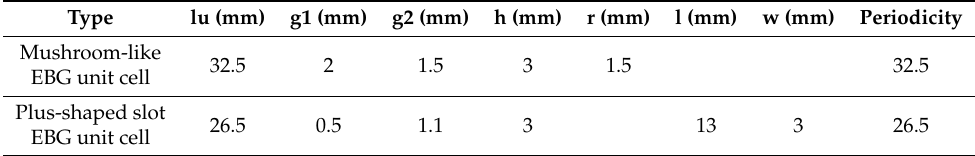
Table 2. Summary of the EBG unit cells